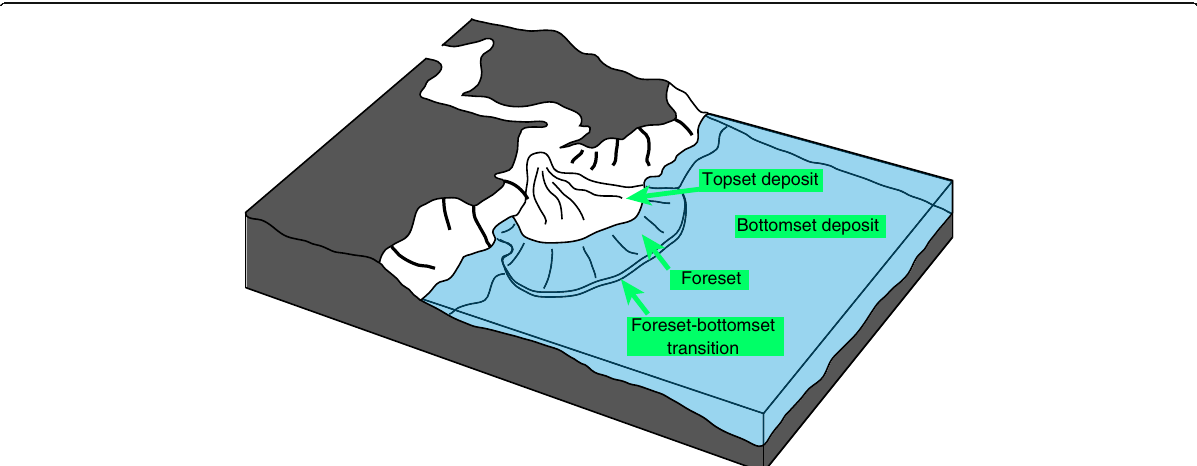
Fig. 4 Structure of a typical deltaic deposit on Mars (modified from Di Achille and Hynek 2010). Schematic diagram illustrates a topset (also called delta plain), foreset (also called delta front), and bottomset deposit (also called delta base), as well as the foreset-bottomset transition. Under the right conditions, the foreset-bottomset transition generates submarine cyclic